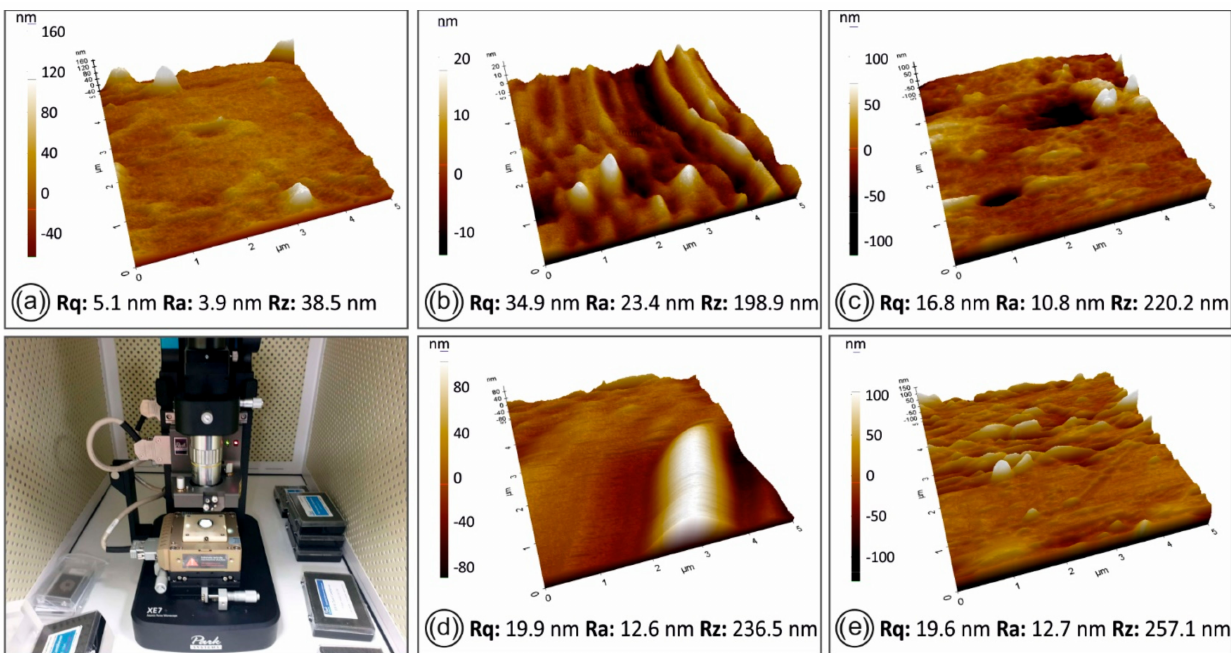
Figure 11. AFM images of the filament side surface for the different materials in this study: ( a ) pure PLA, ( b ) PLA/SiO 2 (0.5 wt.%), ( c ) PLA/SiO 2 (1.0 wt.%), ( d ) PLA/SiO 2 (2.0 wt.%), ( e ) PLA/SiO 2 (4.0 wt.%) nanocomposites, respectively. On the bottom left picture, the experimental setup for the AFM measurements is